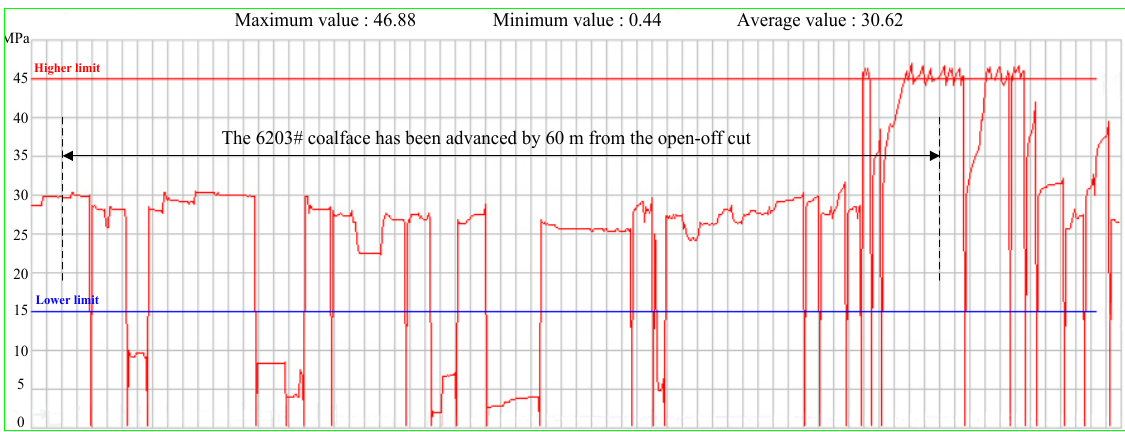
Figure 16. The working resistance of hydraulic supports during the first weighting. Maximum value : 46.88 Minimum value : 0.44 Average value : 30.62